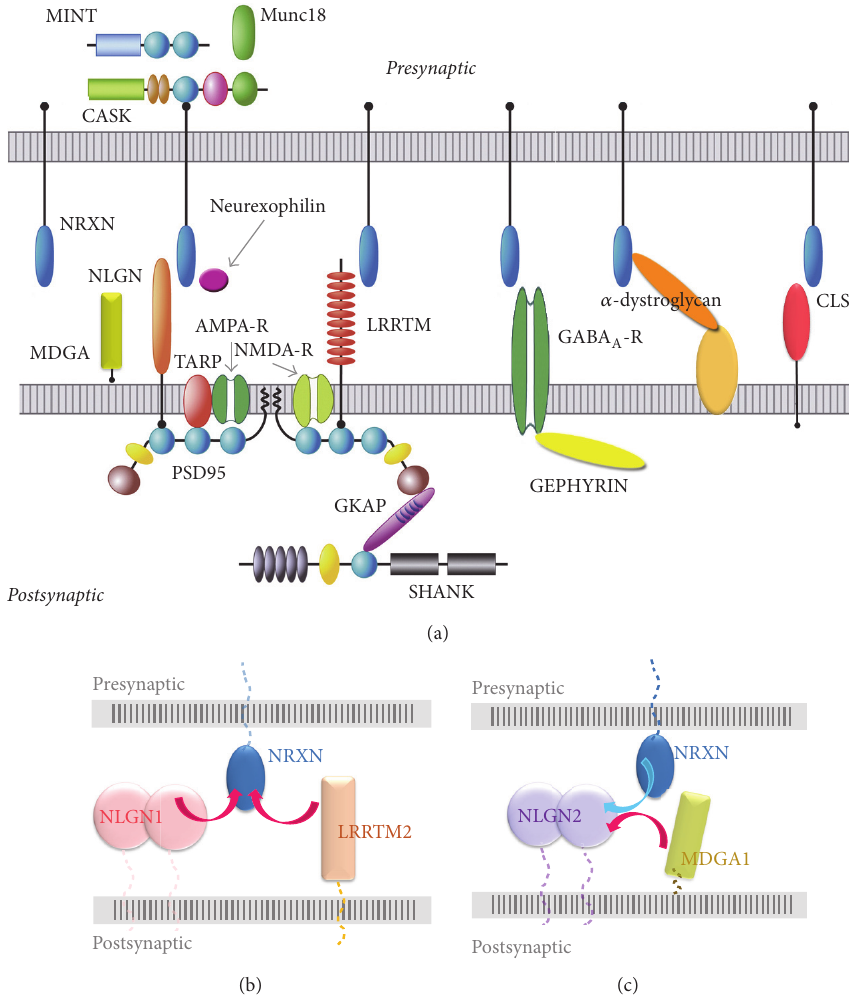
Figure 4: Synaptic protein interaction network coordinated by neurexins. (a) Neurexins (blue ovals) bind many protein partners tethered to the postsynaptic membrane including neuroligins, LRRTMs, 𝛼 -dystroglycan, calsyntenins (CLSTN), and the GABA partners that are secreted such as neurexophilins. (b) NLGN1 and LRRTM2 can both bind neurexins at an overlapping binding site generating two competing trans -interactions. (c) Neurexins and MDGA1 can both bind NLGN2 at an overlapping binding site generating competing cis - and trans